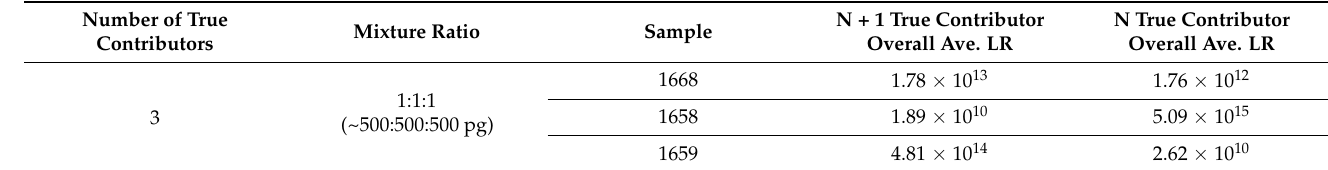
Table 6. Summary of the average (N = 5) calculated LR results of the N + 1 NOC tests for each of the component samples in its respective mixture. The contributors are listed in the order of the position and ratio that they occupied in the mixture. The four-person mixtures altered the sample order, depending on the ratio being tested, for additional variability. All data shown are from undiluted samples, with the approximate quantities of DNA template in each mixture indicated. Overall (sub-sub-source) LRs consider the position of the individual contributor in the mixture, while simple (sub-source) LRs do not. The average overall (sub-sub-source) LR values for each mixture contributor calculated with the true NOC is included for